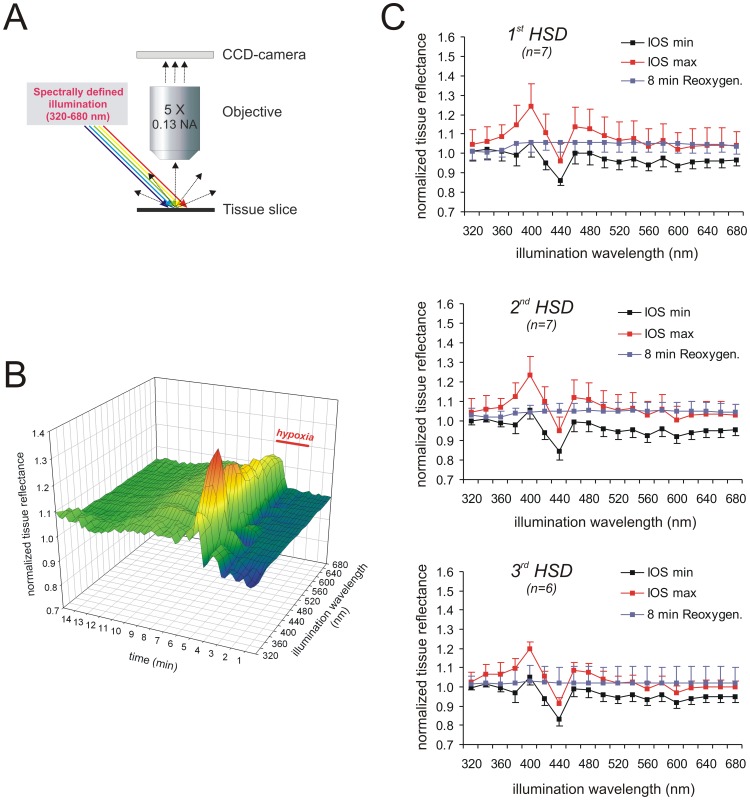
Temporo-spectral properties of the IOS. A) For multispectral IOS recordings the slice was illuminated at an angle of 45°. The illumination wavelength was varied from 320 nm to 680 nm in 20-nm increments, and a full reflectance spectrum was recorded every 15 s. B) Sample recording of the multispectral IOS associated with HSD under control conditions. The changes in light reflectance are normalized to normoxic baseline reflectance and displayed as a surface plot by plotting them versus the respective wavelength and time. The duration of hypoxia is indicated. C) Averaged reflectance profiles obtained at the 3 defined time points (see Fig. 1A) during repeated hypoxia: minimum reflectance early during hypoxia before HSD onset (IOS min), maximum reflectance increase during HSD (IOS max), secondary reflectance increase during posthypoxic recovery 8 min after oxygenation was restored. Note that repeated hypoxia separated by 20 min of recovery did not affect the averaged reflectance profiles. The number of slices analyzed is reported; error bars represent standard deviations.